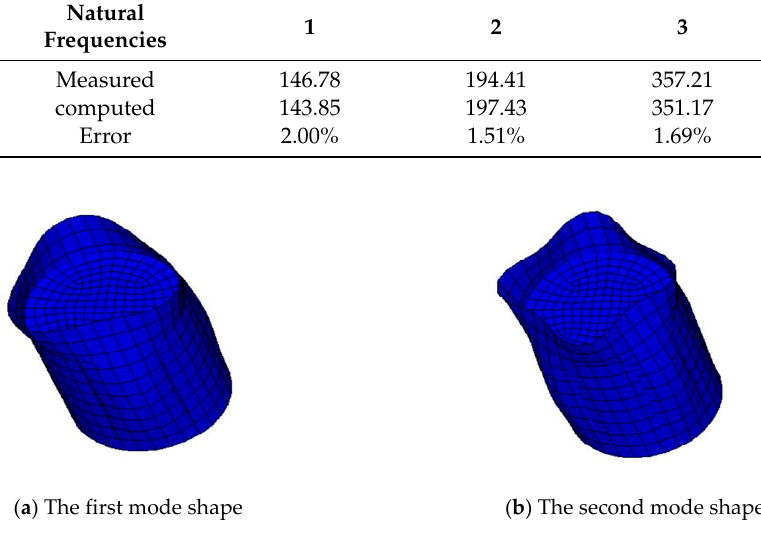
Figure 24. The first two mode shapes of the liquid storage tank.